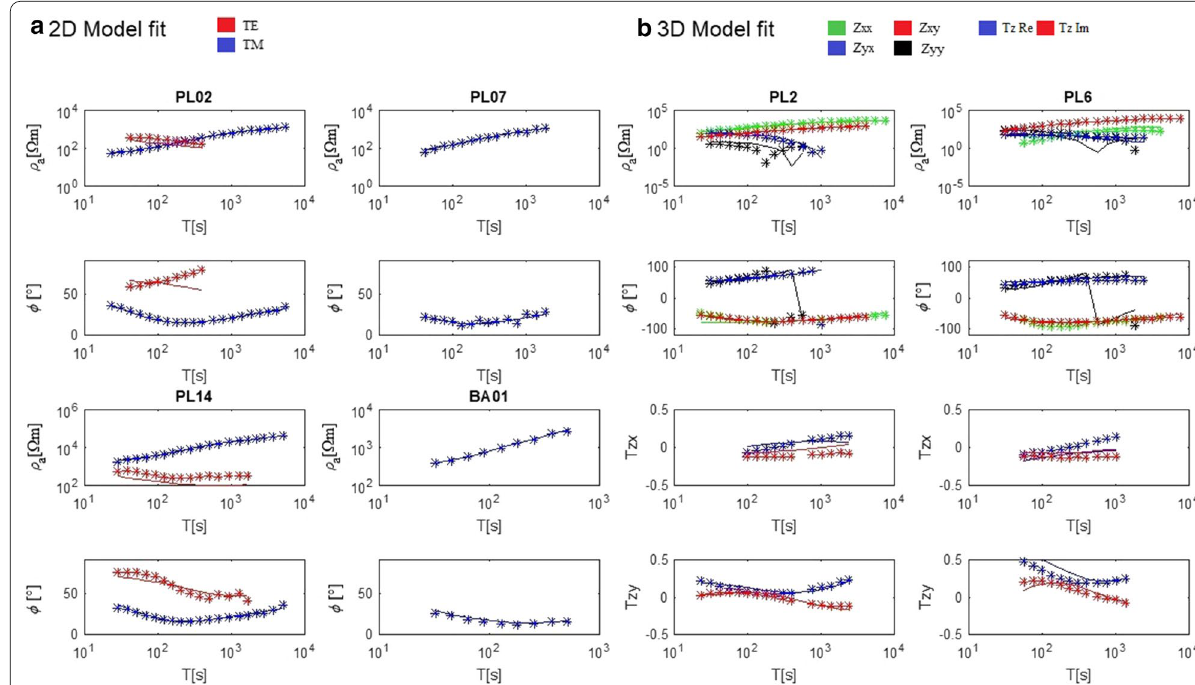
Fig. 6 To make the comparison between measured data (asterisk) and model response (continuous lines) at four exemplary sites. a 3D model fit curves best and worst fitting curves. b 2D model fit curves best and worst fitting